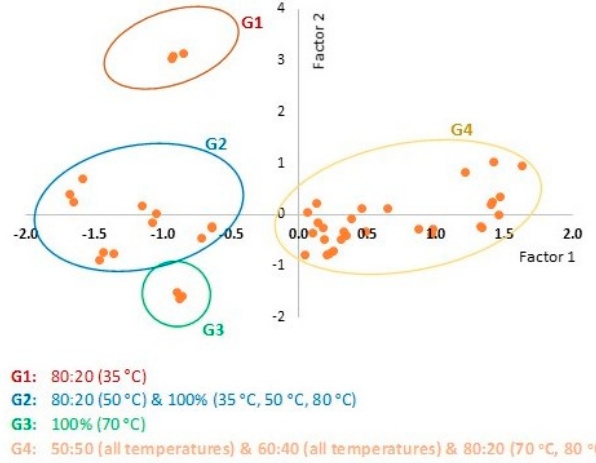
Figure 6. Grouping structure according to both factors extracted.